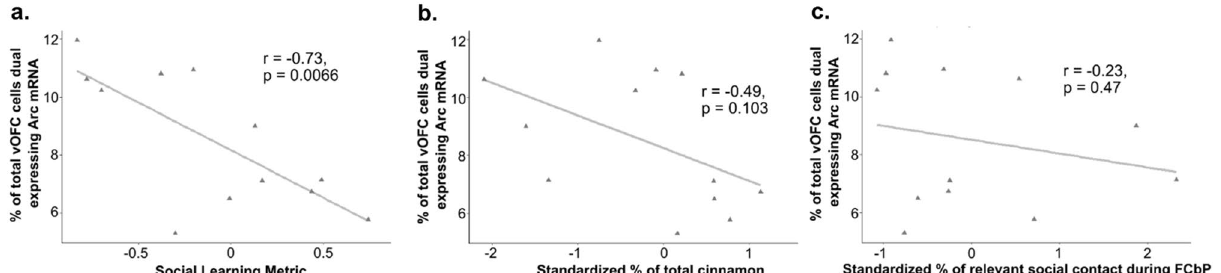
Figure 8. Relationship between social learning measures dual Arc expression in the vOFC. ( a ) A significant negative relationship was found between a social learning metric calculated by summing standardized measures of social acquisition of the STFP and socially acquired fear association in Observers and the percent of Arc dual- expressing cells in the ventral orbitofrontal cortex. This relationship was not significant when looking at either ( b ) the standardized measure of STFP or ( c ) the standardized measure of sex relevant social contact during FCbP—used as a proxy for social fear learning—alone. Notably, both male and female rats were included in this